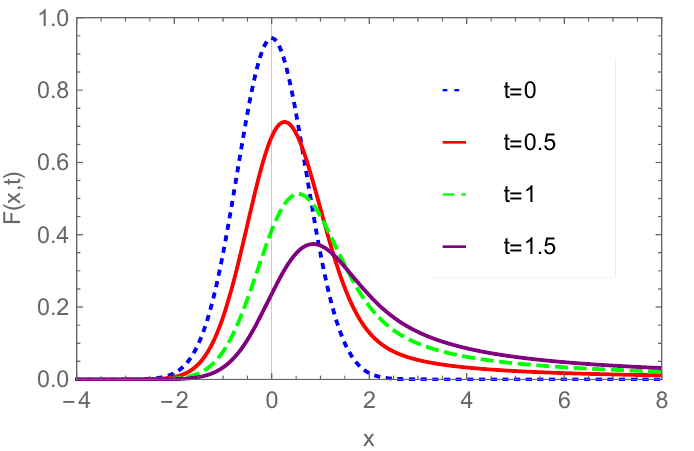
Figure 1. Solution F ( x , t ) of Equation (21) at different times t , for α = 1 being a